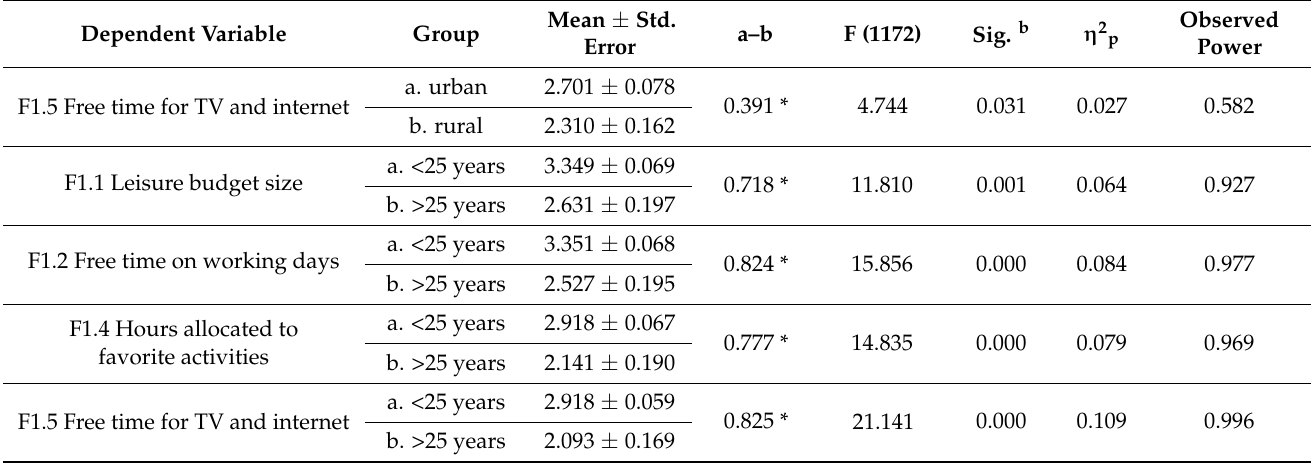
Table 3. The results of univariate tests/ANOVA and the comparison in pairs of the average values at the level of the items for factor 1 (leisure